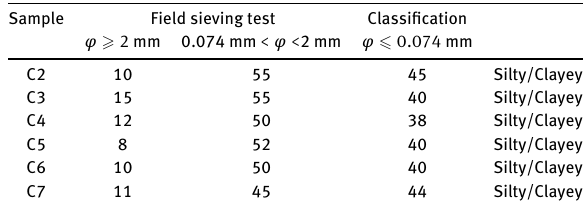
Table 3: Field sieving